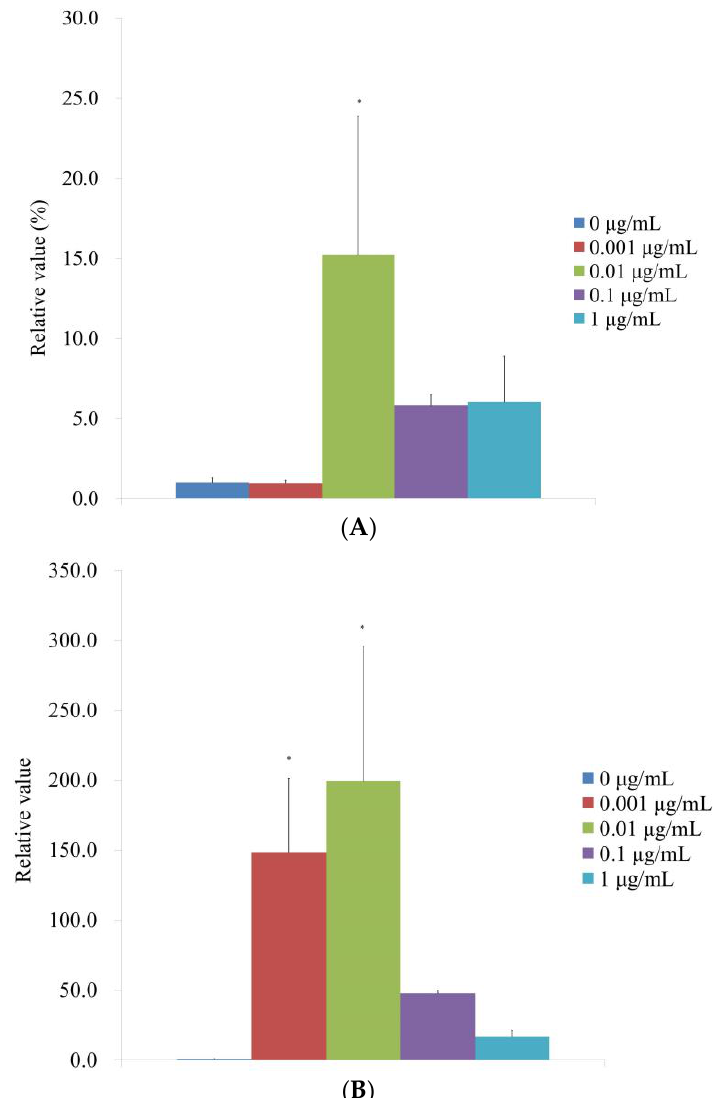
Figure 7. Evaluation of mRNA expression in terms of quantity on Day 14. ( A ) Real-time polymerase chain reaction measurement of RUNX2 mRNA expression on Day 14. * p < 0.05 versus the 0 µ g/mL on Day 14. ( B ) Real-time polymerase chain reaction measurement of COL1A1 mRNA expression on Day 14. * p < 0.05 versus the 0 μg /mL on Day 14.